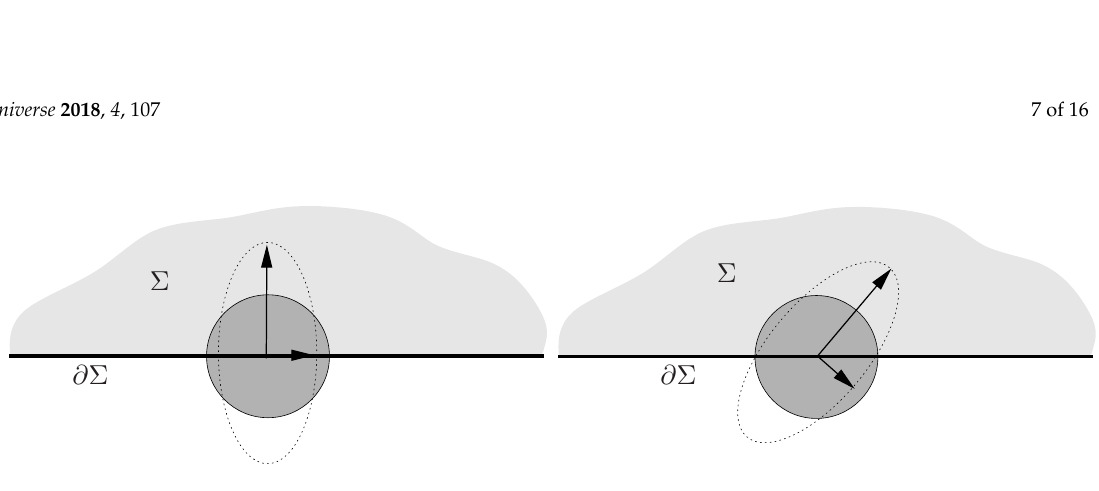
= 0: the principal axis of the ξ = 0, the boundary (cid:54) = 0, the boundary “moves”. ξ ̸